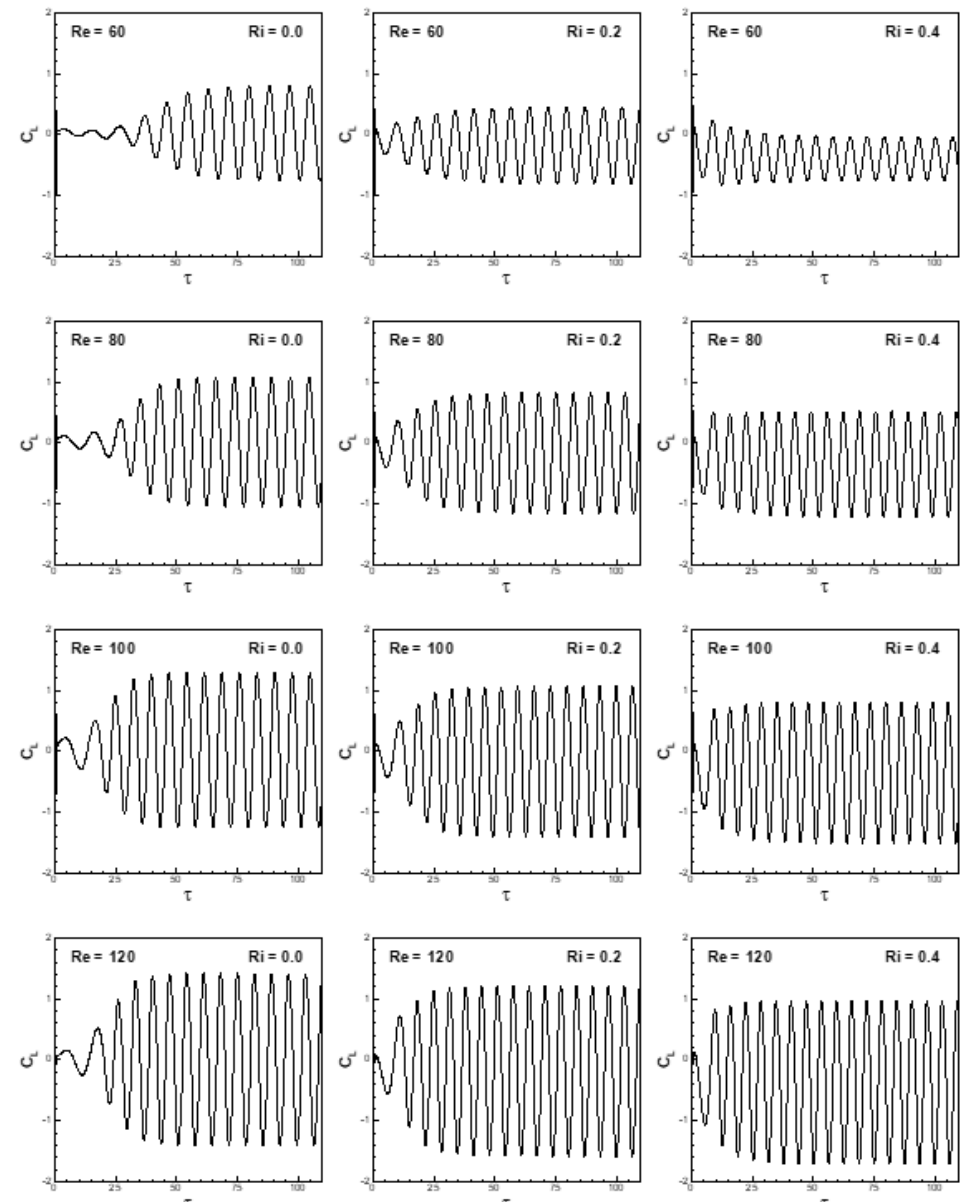
Figure 20. Temporal variation of lift coefficient in the forced and mixed convective flow regime at a free-stream orientation of 45°, 0 ≤ Ri ≤ 0.4 and 60 ≤ Re ≤ 120.